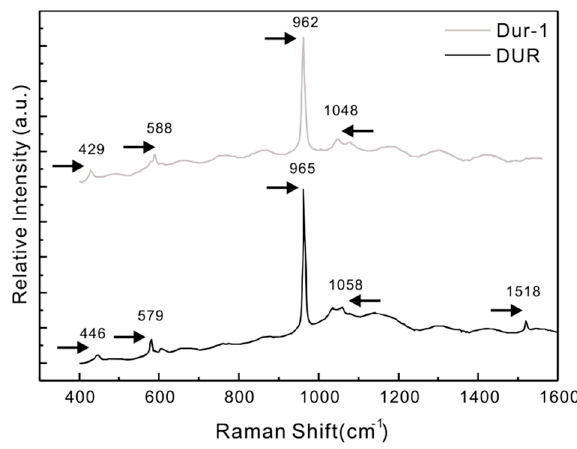
Figure 4. Raman spectra from selected grains of Durango apatite.